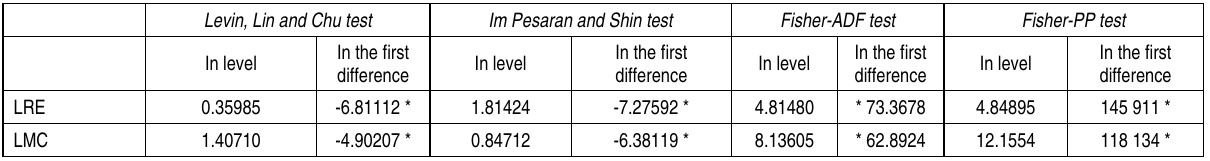
Table 5 (cont.). The unit root test